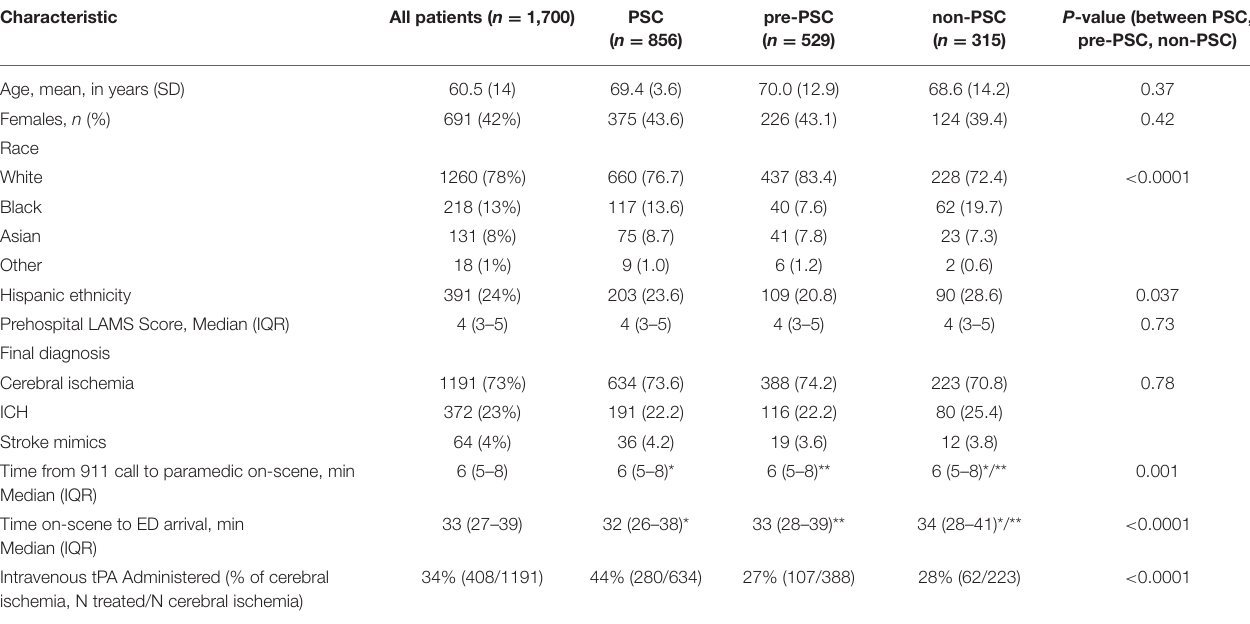
P -value (between PSC, pre-PSC ( n = 856) ( n = 529) pre-PSC, non-PSC)